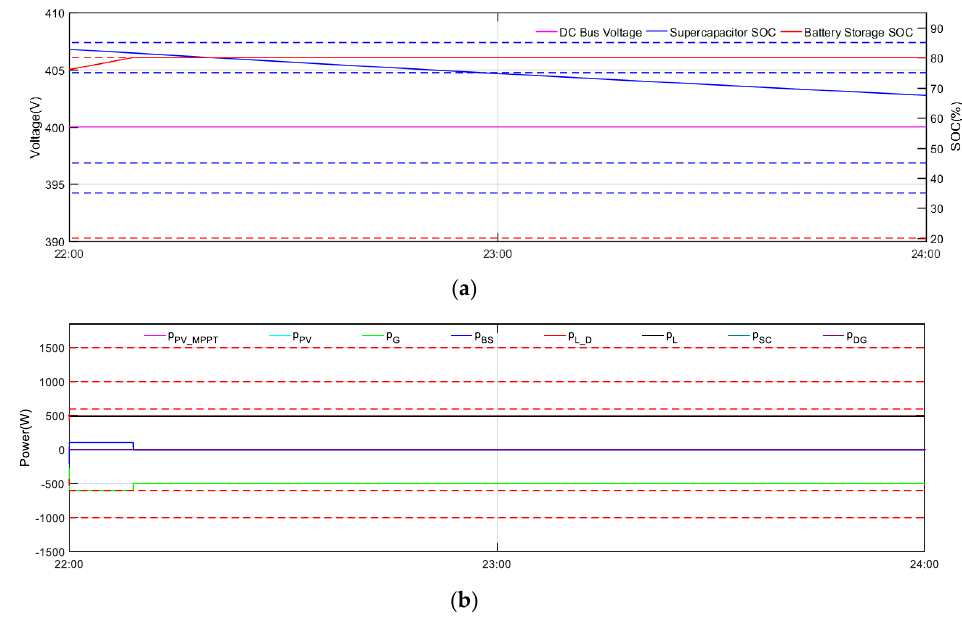
Figure 17. Curves of common DC bus voltage and SOC of storage ( a ) and curves of power ( b ) during the period